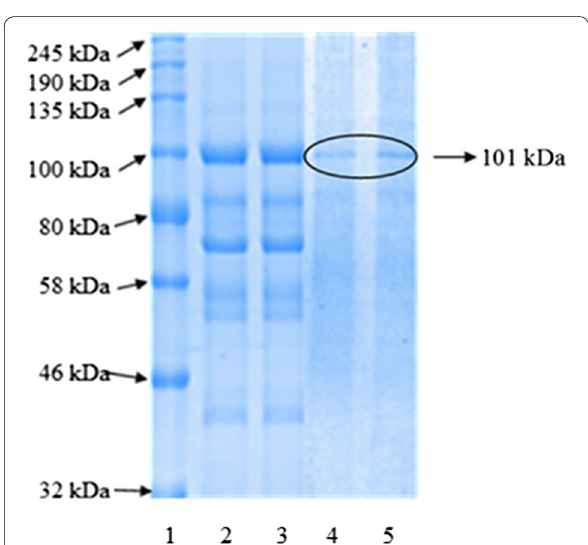
Fig. 4 12% SDS-PAGE analysis of the AMG (Laemmli 1970): lane 1 is colour pre-stained standard, broad range (BioLabs); AMG crude enzyme (lanes 2, 3); the post-gel filtration chromatography protein bands (lanes 4,